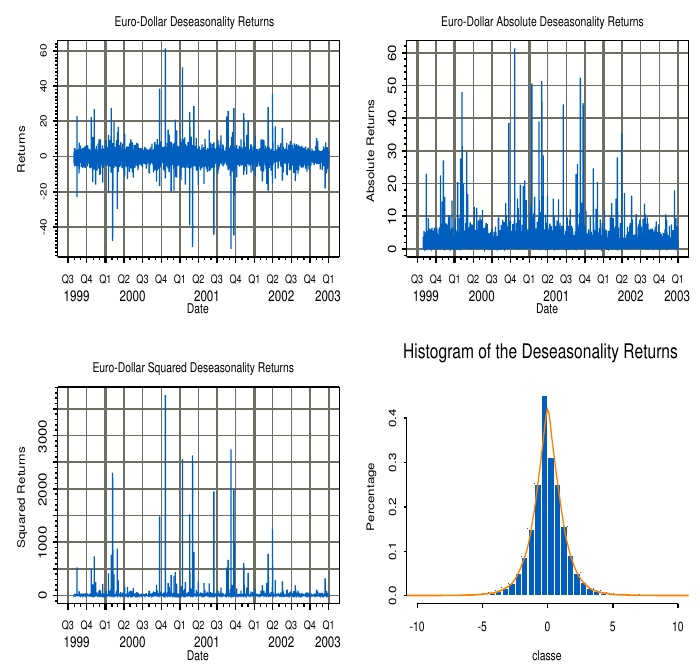
Figure 4. Euro-Dollar returns, absolute returns, squared returns and histogram after taking off seasonal